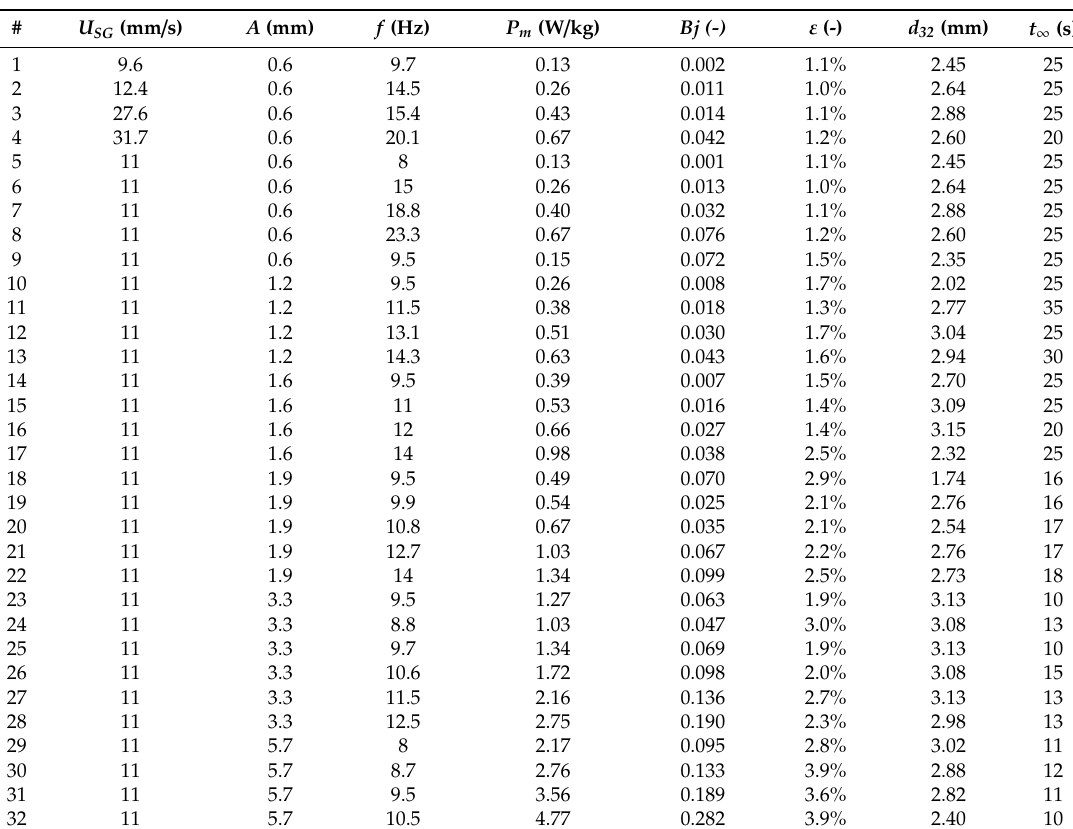
Table 2. Summary of test conditions with vertical